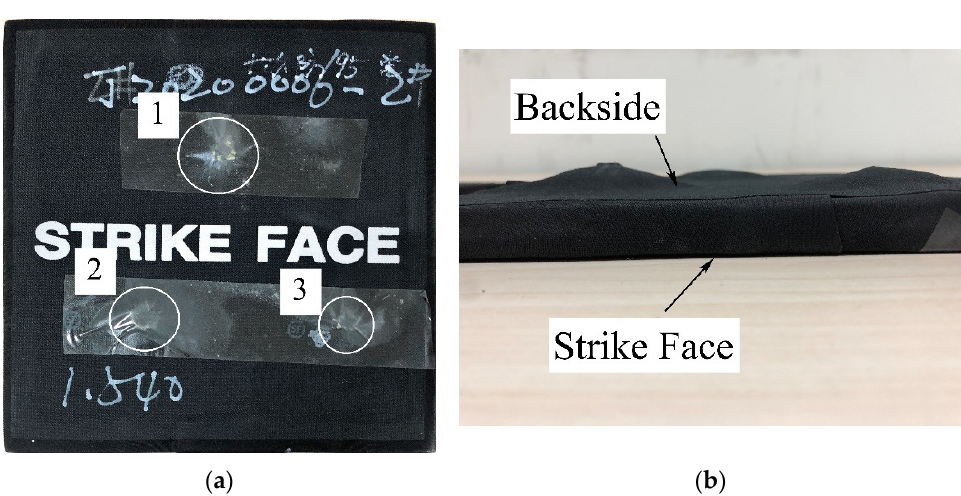
Figure 8. The images for the pure-matrix sample after the SA test; ( a ) front view (the ballistic hitting sequence was labeled); ( b ) side view.